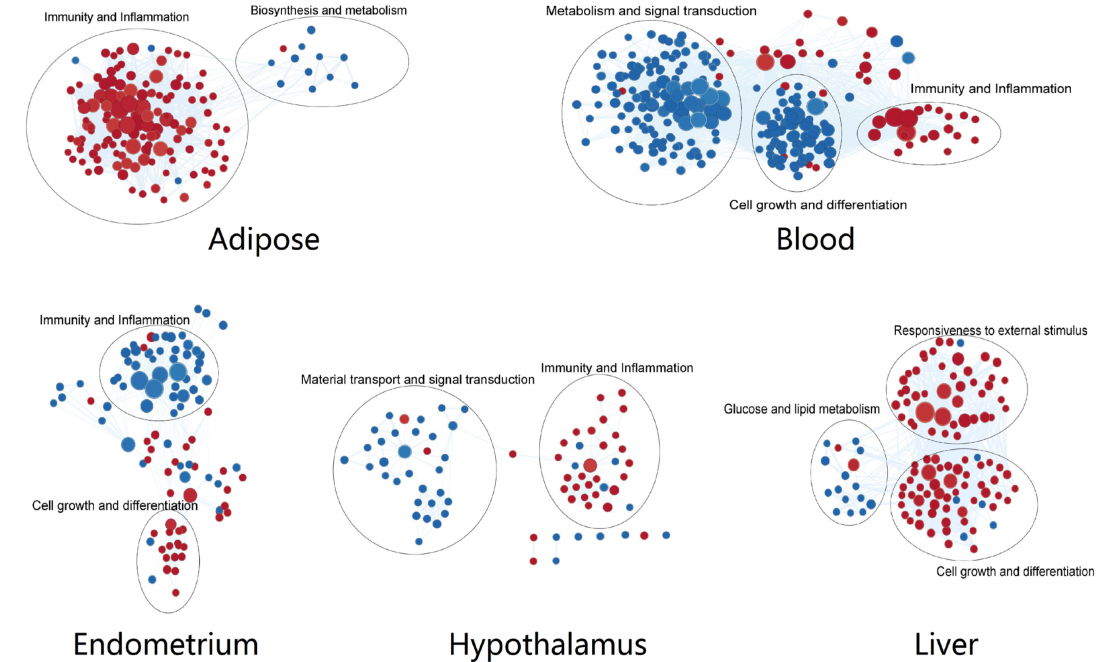
Figure 3. Cluster of the GO(BP) terms from every tissue. Red dots for up-regulated processes in NEB group and blue dots for down-regulated